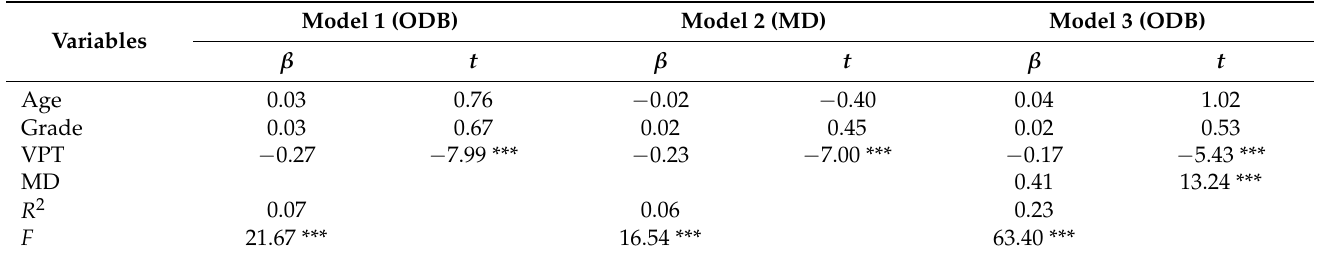
Table 2. Testing the mediation effect of virtuous personality trait on online deviant